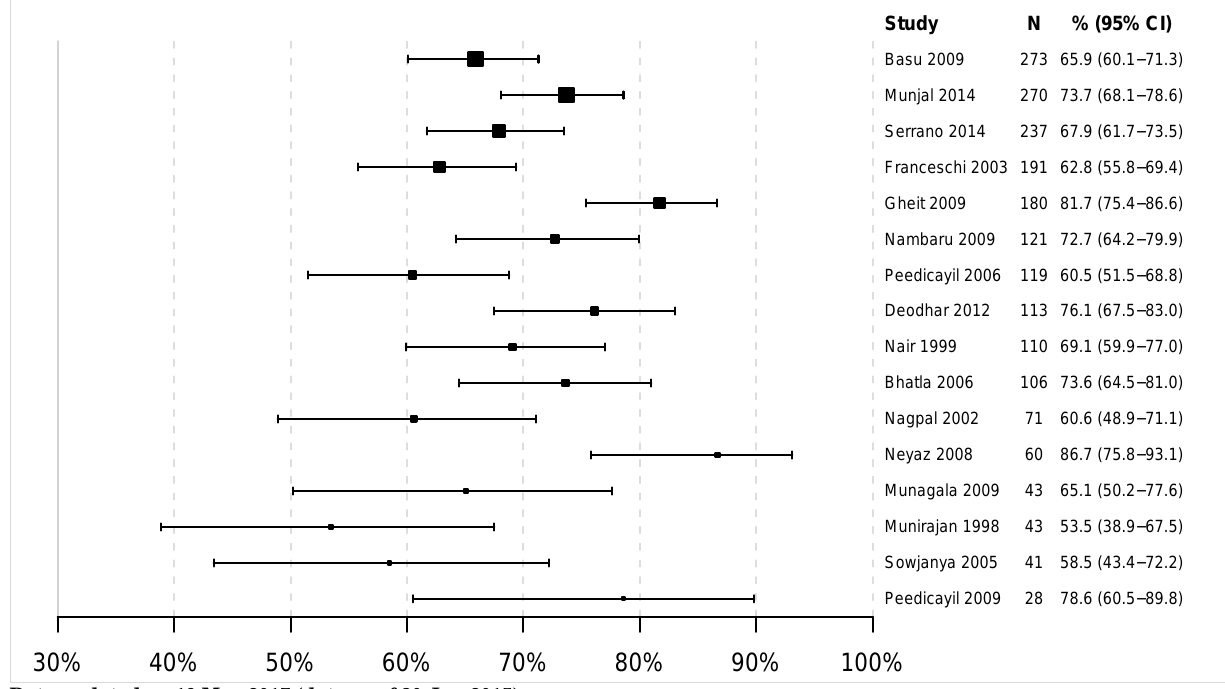
Figure 59: HPV 16 prevalence among women with invasive cervical cancer in India, by